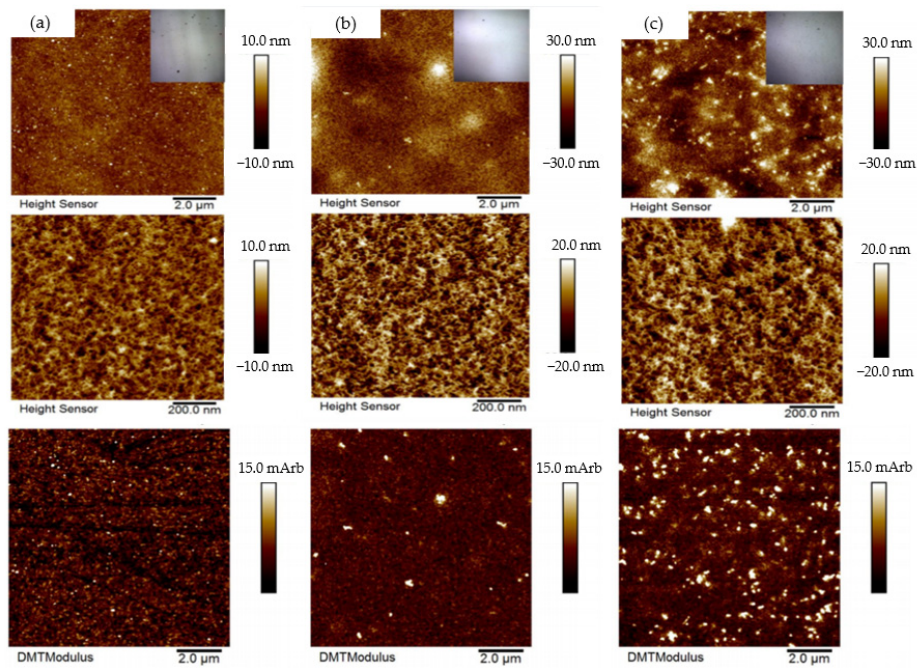
Figure 8. AFM topology images of ( a ) neat PDMS; ( b ) PDMS with 3 wt.% SiO 2 and ( c ) PDMS with 5 wt.% SiO 2 .